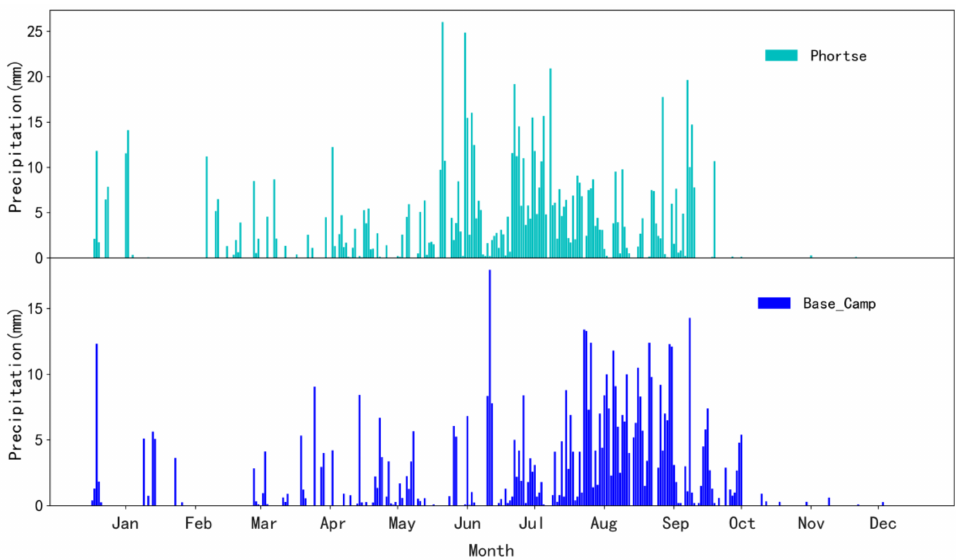
Figure 5. Total daily precipitation at Phortse and Base Camp in